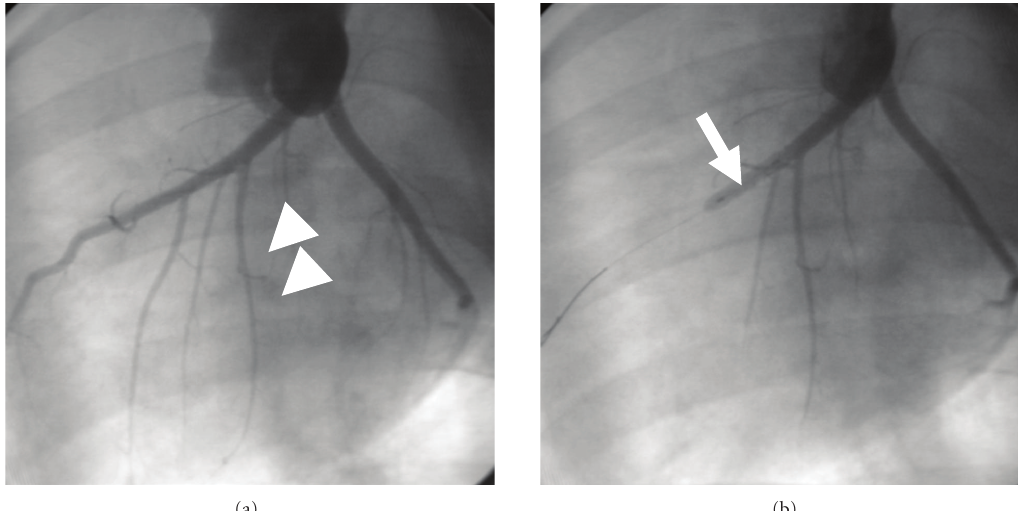
Figure 2: Baseline coronary angiogram was obtained for assessment of anatomic information of the LAD (a). The LAD with the first large diagonal artery (white arrowhead) is delineated. Angiographic confirmation of complete occlusion in the midportions (b) of the LAD with a PTCA balloon catheter (white arrow). Adapted from [12].